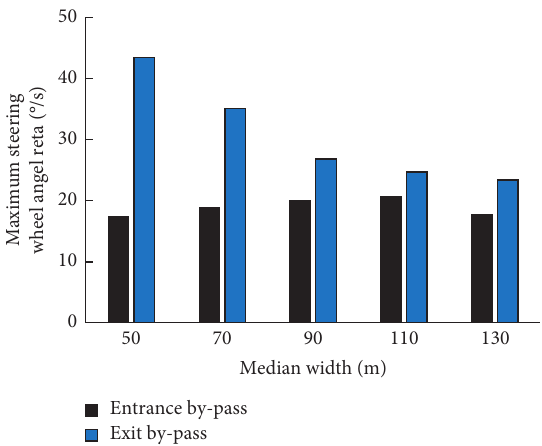
Figure 5: Steering wheel angel rate changes with median